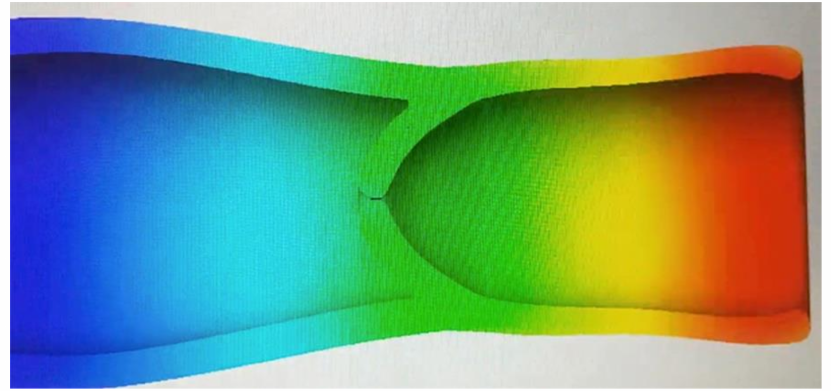
Figure 8. Version 1.0 of the lymphatic vessel: deformation test with closed valve (2020).